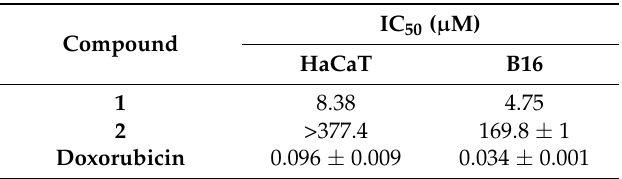
Table 3. Cytotoxic assay of Compounds 1 and 2 .